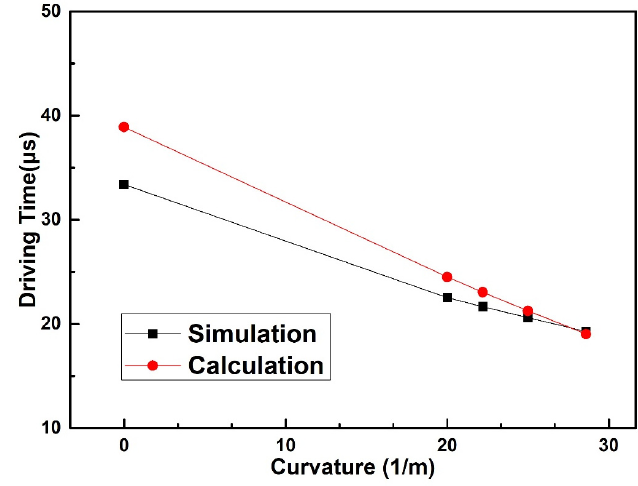
Figure 5. Simulated driving time of the spring-like double-clamped beam switch with different substrate curvatures.